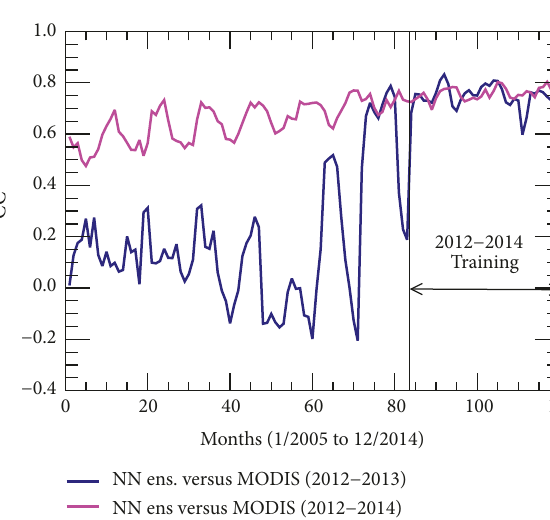
Figure 4: Mean differences: MODIS versus VIIRS and MODIS versus SeaWiFS. Figure 5: Correlation between chl-a simulated by two NN ensem- bles.BlackcurveshowsresultsforNNensembletrainedontwoyears (2012 and 2013) and pink curve for NN ensemble trained on three (2012 to 2014) of daily VIIRS